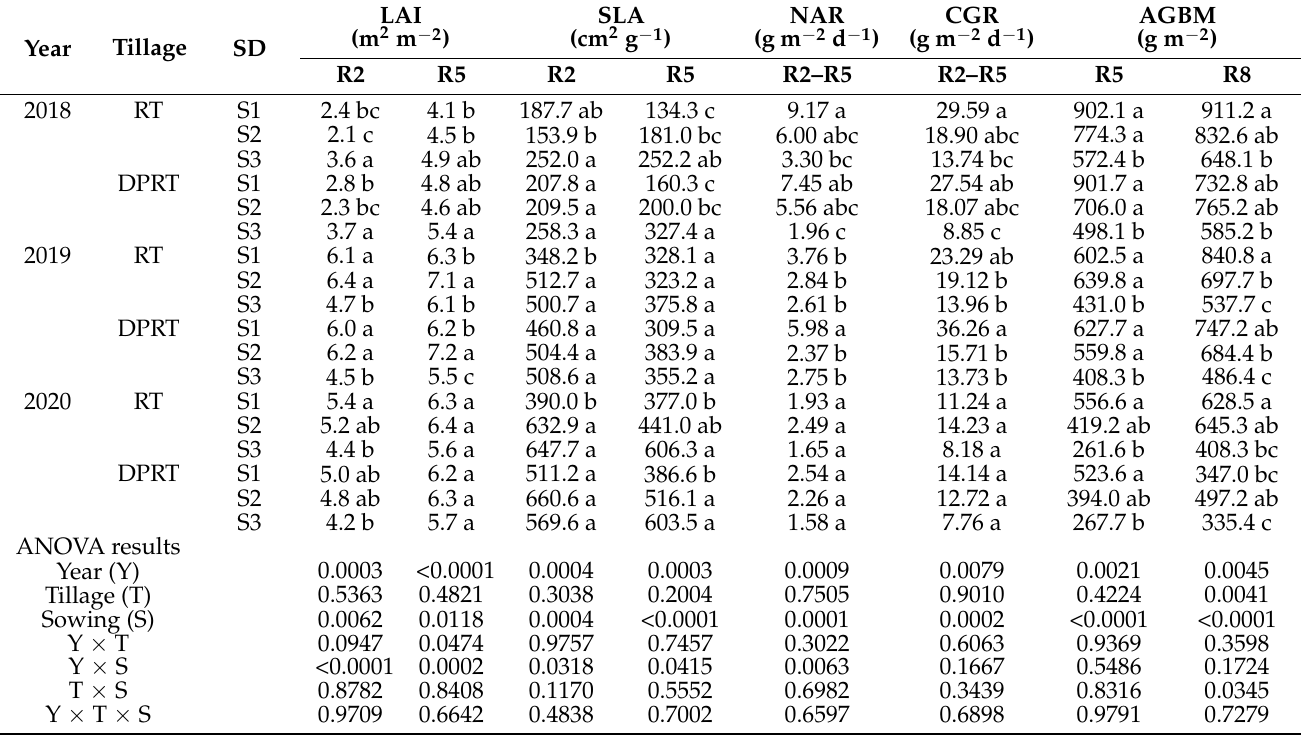
Table 3. Growth parameters of double-crop soybeans grown in drained paddy fields with different tillage systems and sowing dates over three seasons (2018–2020). ANOVA (analysis of variance) results ( p -values) are given for each